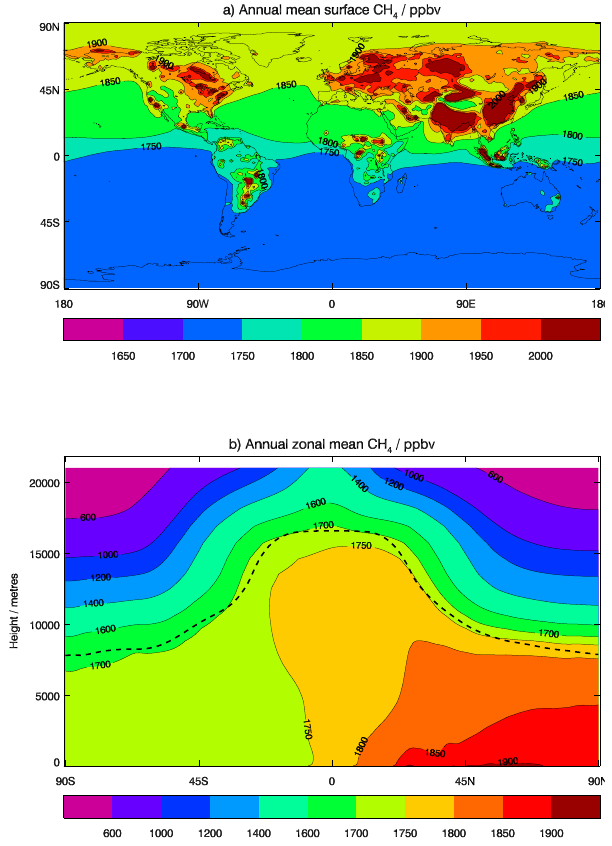
Fig. 12. Multi-annual (a) surface and (b) zonal mean CH 4 distributions from the StdTrop chemistry scheme in the tropospheric configuration of the UKCA model. The thick dashed line in (b) marks the position of the modelledtropopause(Hoerlingetal.,1993).